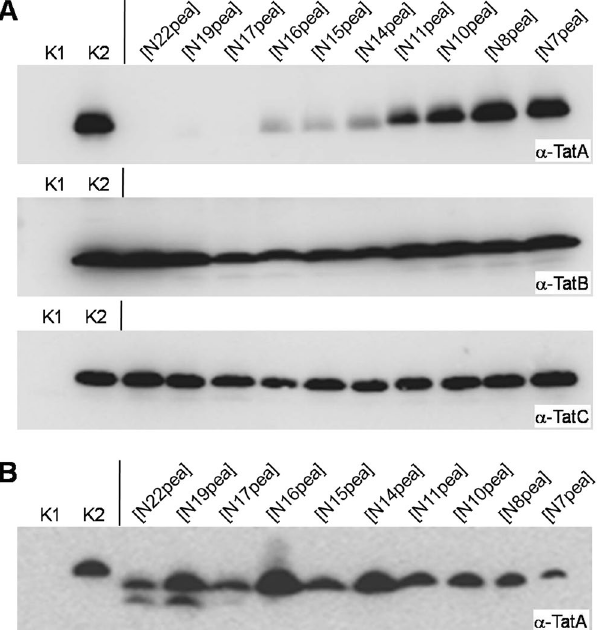
Figure 7. Accumulation of chimeric TatA proteins in E. coli . ( A ) Membrane preparations corresponding to identical amounts of cells were subjected to SDS-PAGE and immunoblotting using polyclonal antibodies raised against TatA (upper panel), TatB (middle panel), or TatC (lower panel) from E. coli . The immunoblots were developed by ECL-coupled detection. ( B ) Whole cell extracts of the cultures shown in ( A ) were analysed. K1, negative control (GSJ101 pTorAMalE, pHSG575); K2, positive control (GSJ101 pTorA-MalE, pHSG-TatABC). The other samples correspond to GSJ101 pTorA-MalE containing in addition pHSG-TatABC plasmids expressing the TatA chimeras indicated above the respective lanes.